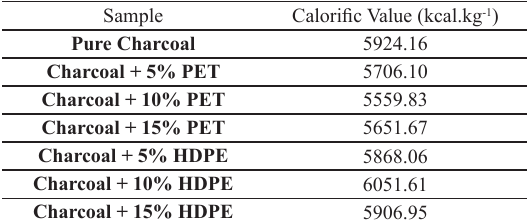
Table 2. Calorific value of pure elephant grass charcoal and charcoal blends with